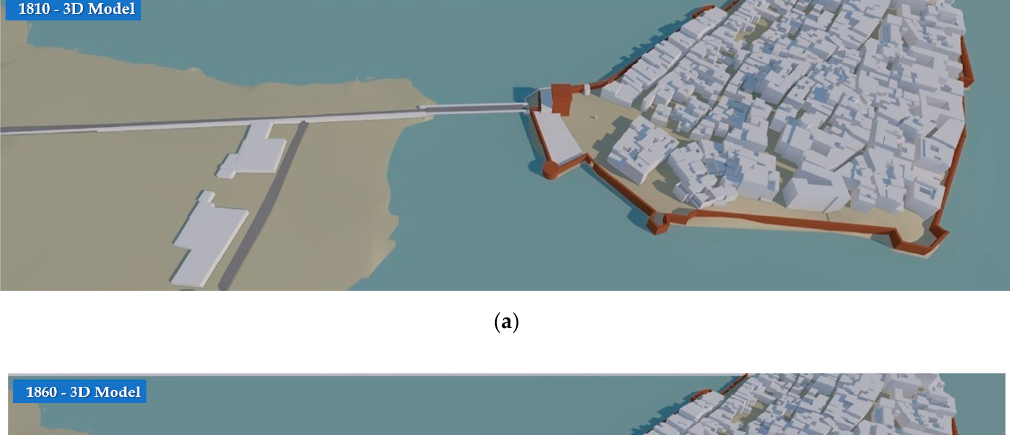
Figure 11 . Digital terrain model (DTM) of study area displayed in the Global Mapper software